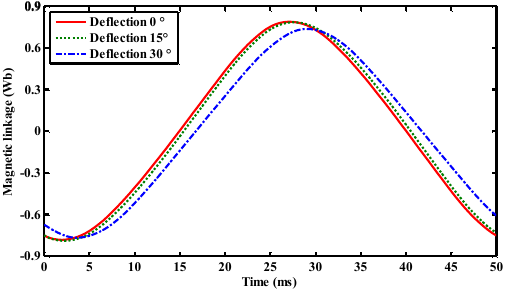
Figure 25. Magnetic linkage comparison diagram of phase A winding in three states.